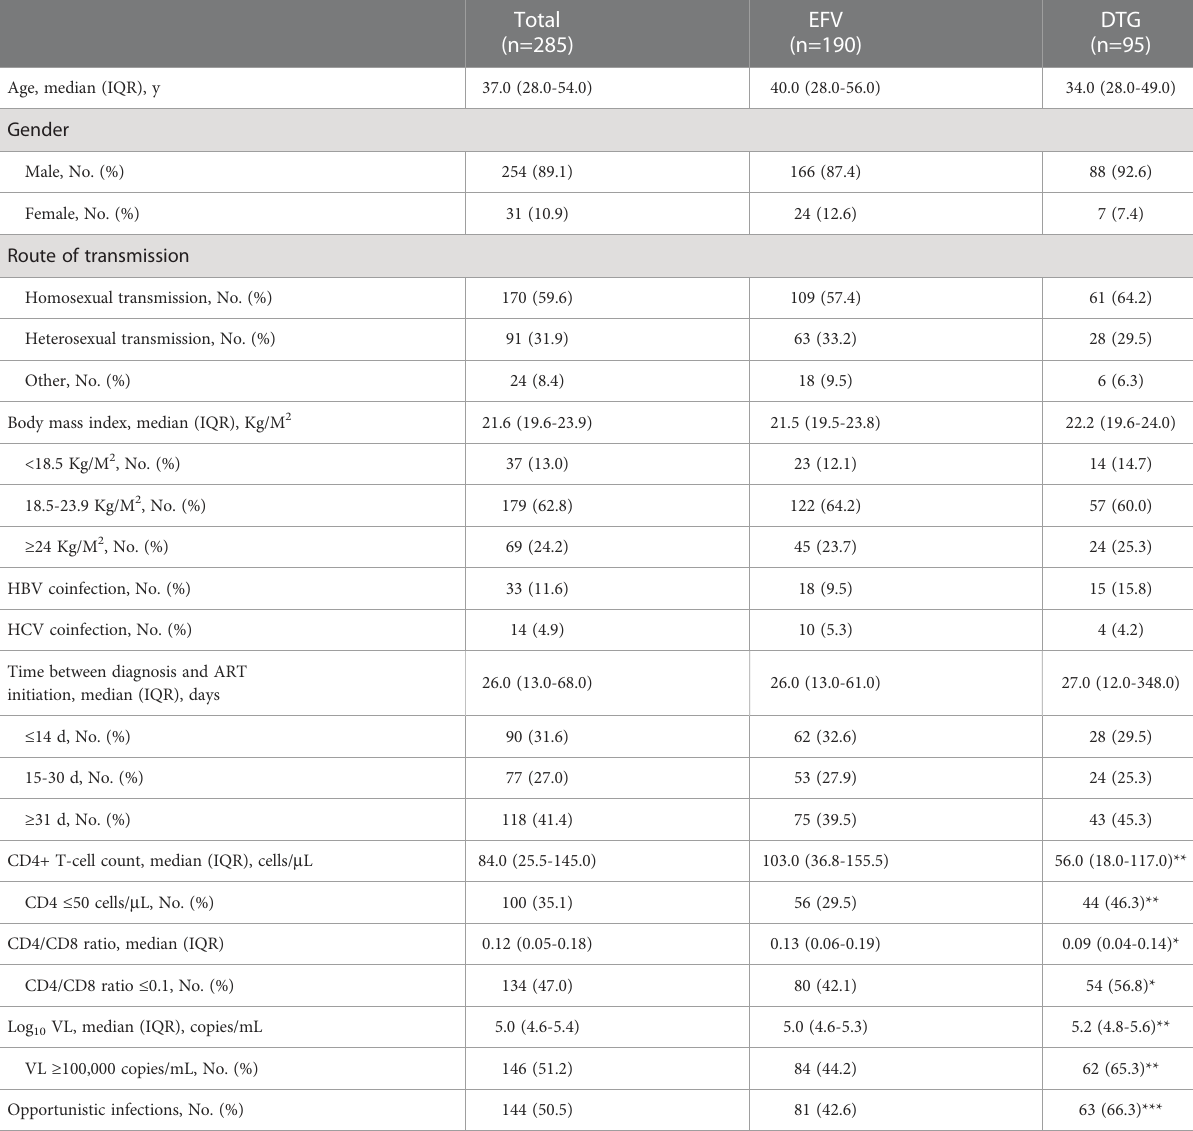
TABLE 1 Baseline demographic and clinical